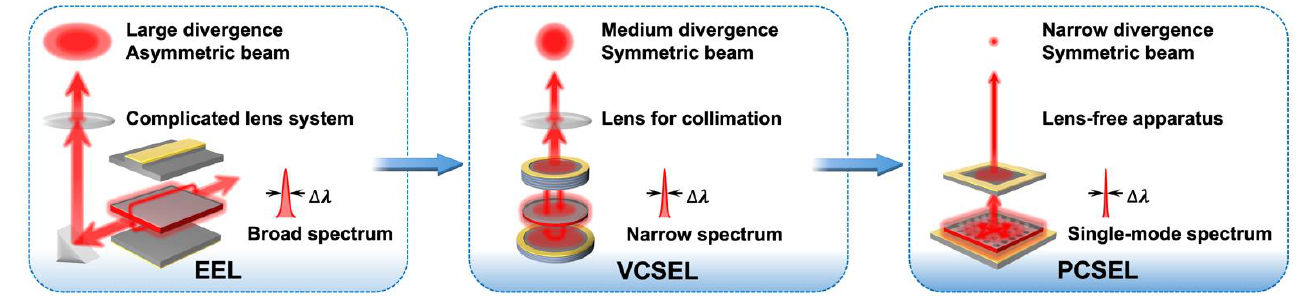
Figure 1. Schematic illustration for the development progress of laser light sources.